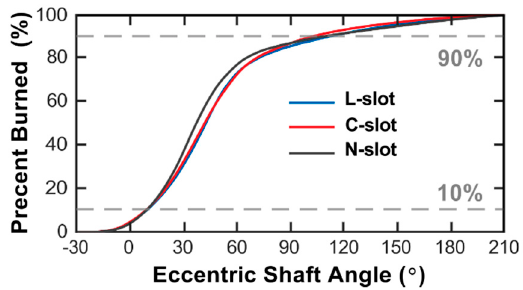
Figure 9. Simulated burned mass percentage for L-slot (baseline), C-slot, and N-slot configurations.